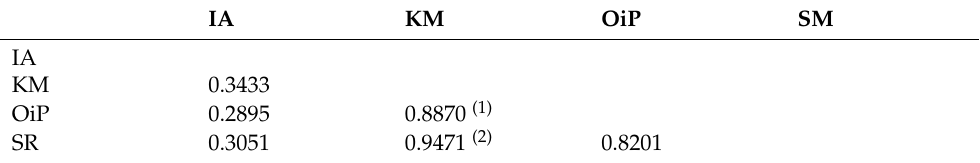
Table 7. Assessment of discriminant validity of the path model in phase three using the HTMT criterion. IA KM OiP